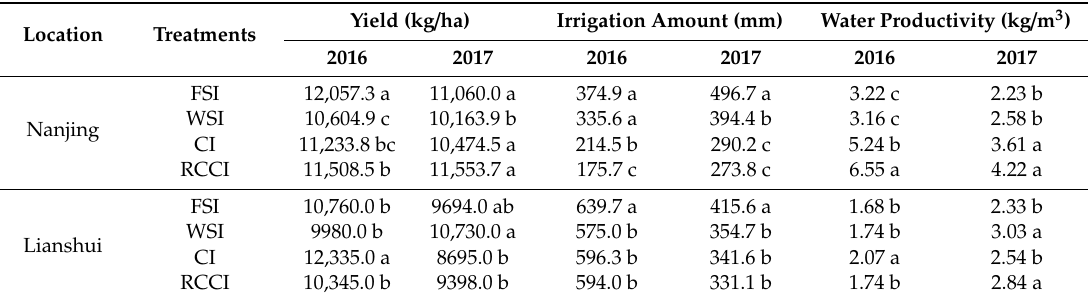
Table 4. Output, irrigation water consumption, and irrigation water productivity under di ff erent irrigation